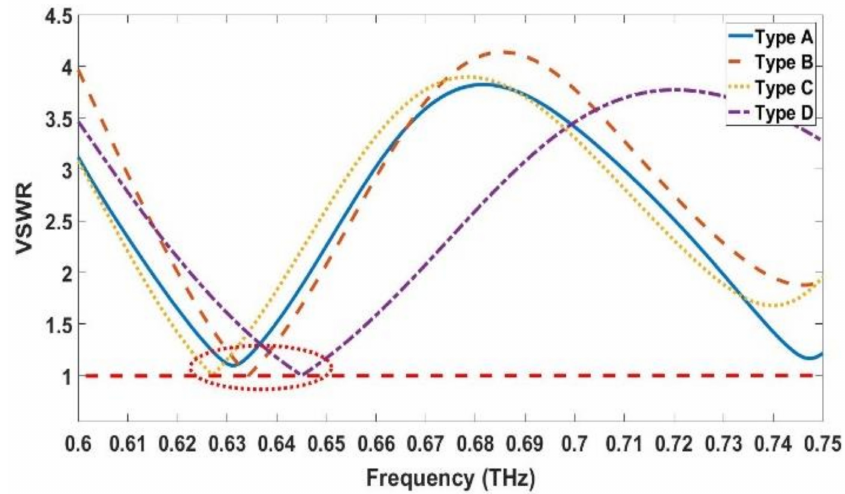
Figure 5. Comparison of VSWR versus operating frequency.